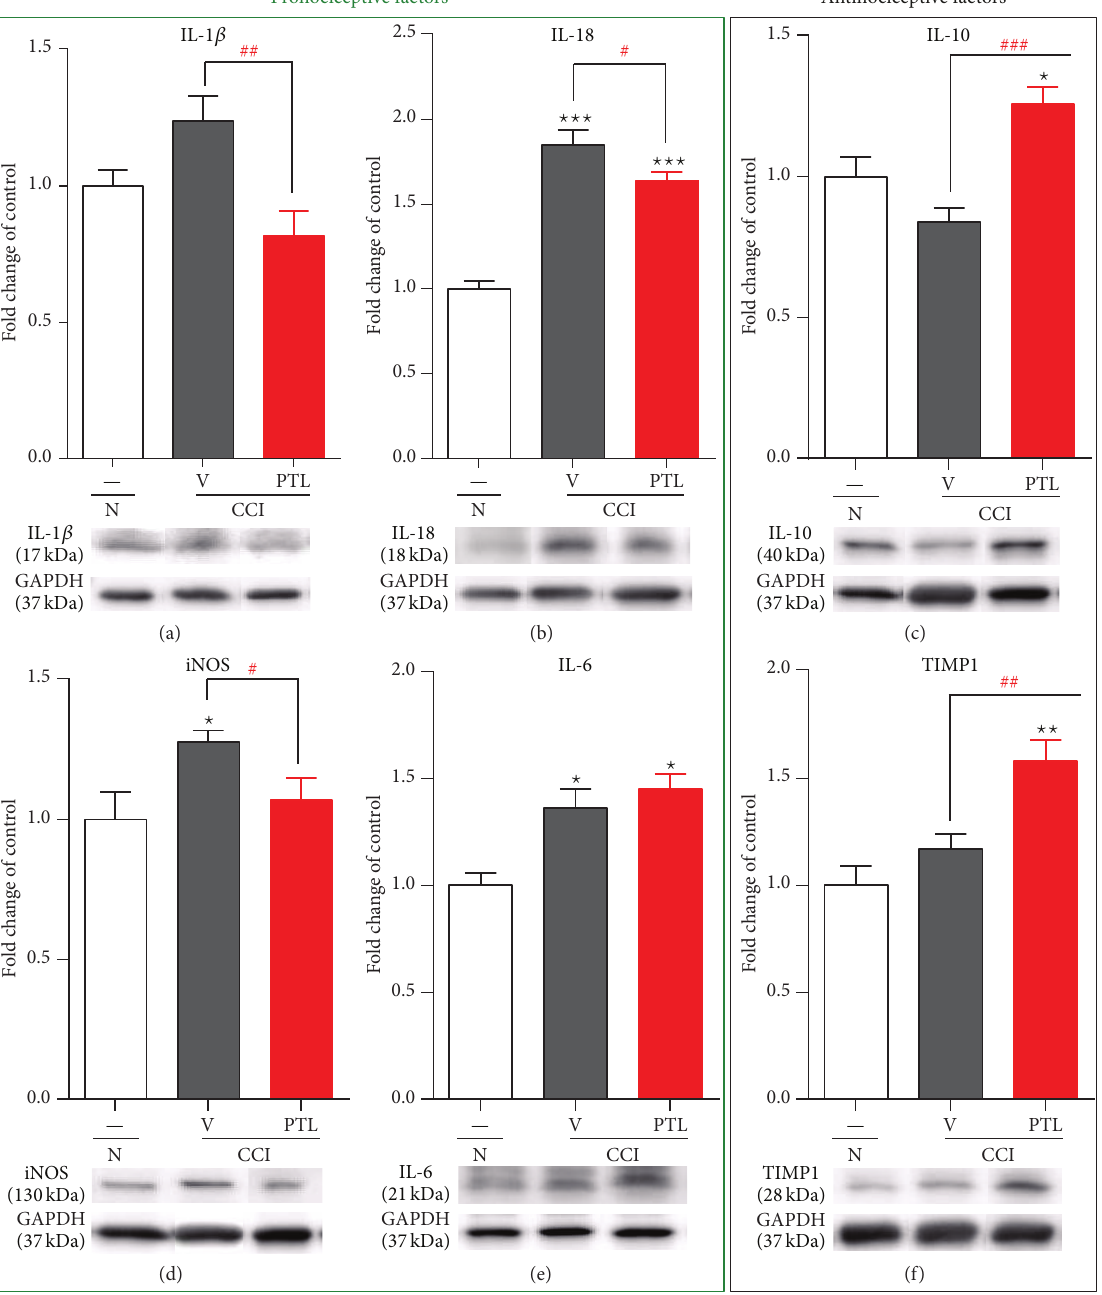
Figure 3: Effects of PTL on the protein levels of pronociceptive (IL-1 𝛽 , IL-18, iNOS, and IL-6) and antinociceptive (IL-10 and TIMP1) factors in the spinal cord 7 days after CCI. The nerve injury caused increased IL-18 (b), iNOS (d), and IL-6 (e) protein levels, but the IL-1 𝛽 (a) protein level was unchanged after CCI. Chronic PTL administration diminished protein levels of IL-1 𝛽 (a), IL-18 (b), and iNOS (d) but did not change IL-6 (e) in the dorsal part of the lumbar spinal cord 7 days after injury. The protein level of IL-10 (c) and TIMP1 (f) was unchanged in the spinal cord following CCI, but repeated administration of PTL significantly increased IL-10 (c) and TIMP 1 (f) proteins compared to those of CCI- exposed rats without PTL treatment. The data are presented as the mean ± SEM of 5–7 samples from each group. Intergroup differences were analyzed using Bonferroni’s multiple comparison test. ∗ 𝑃 < 0.05 , ∗∗ 𝑃 < 0.01 , and ∗∗∗ 𝑃 < 0.001 indicate significant differences compared to na¨ıve rats. # 𝑃 < 0.05 , ## 𝑃 < 0.01 , and ### 𝑃 < 0.001 indicate differences between vehicle-treated and PTL-treated CCI-exposed group. N-na¨ıve, V-vehicle, and PTL-parthenolide. The immunoblots shown are representative of 5–7 individual